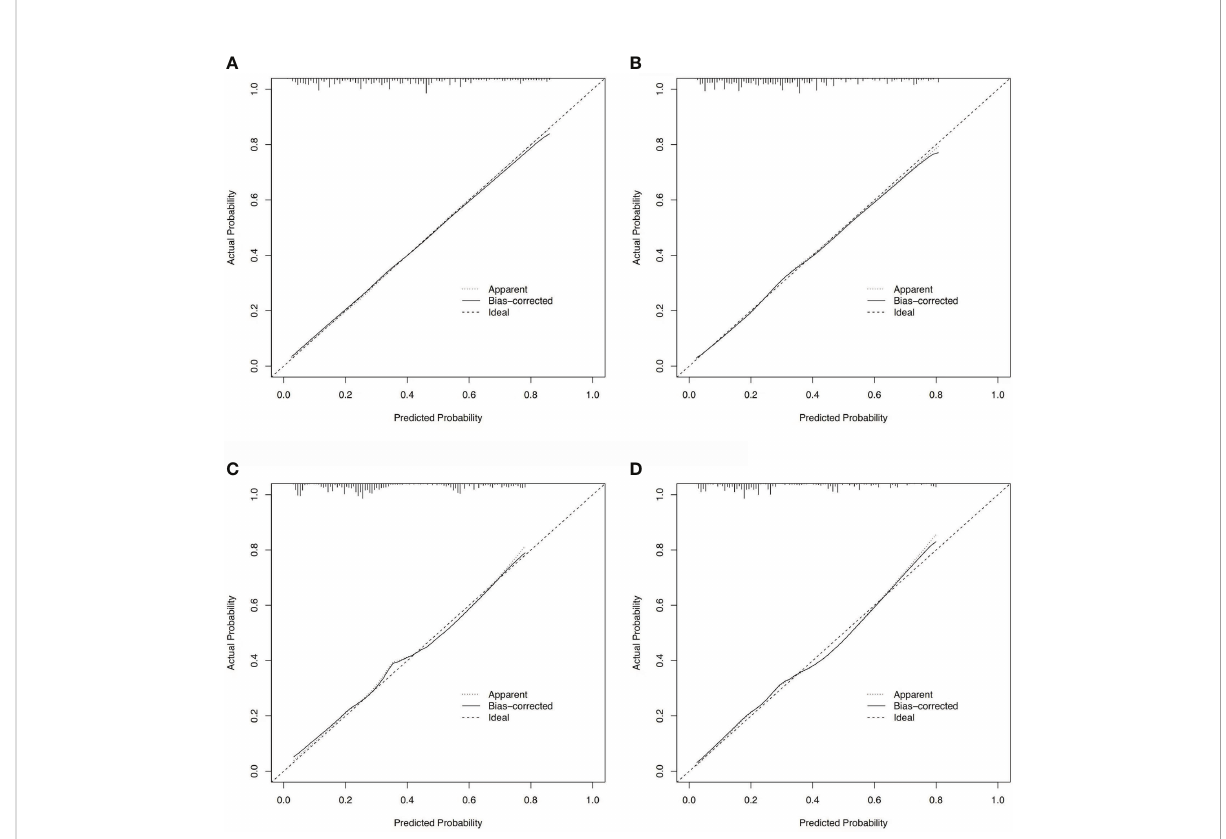
FIGURE 5 Calibration curves for assessing the calibration of the nomogram in predicting all-cause and cancer-speci fi c early death in the training cohort (A, B) and the validation cohort (C, D)